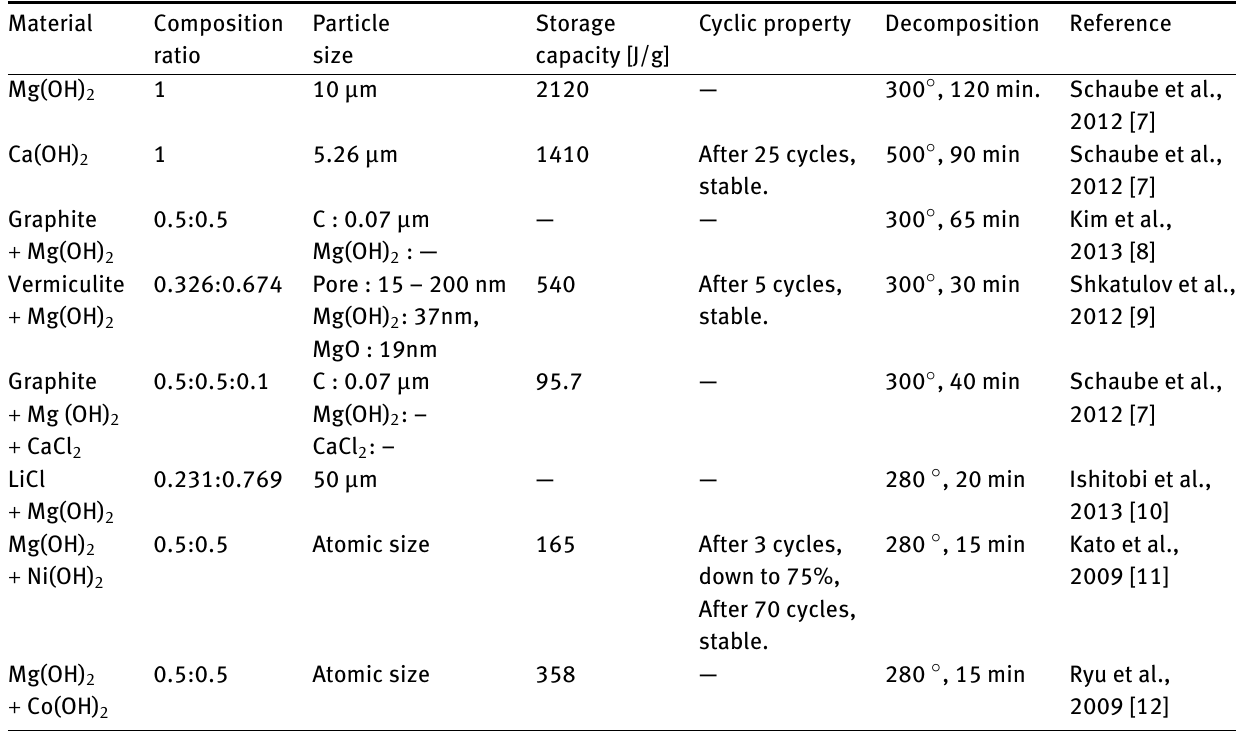
Table 1: Properties of the co-precipitated metallic hydroxide nano-composites.